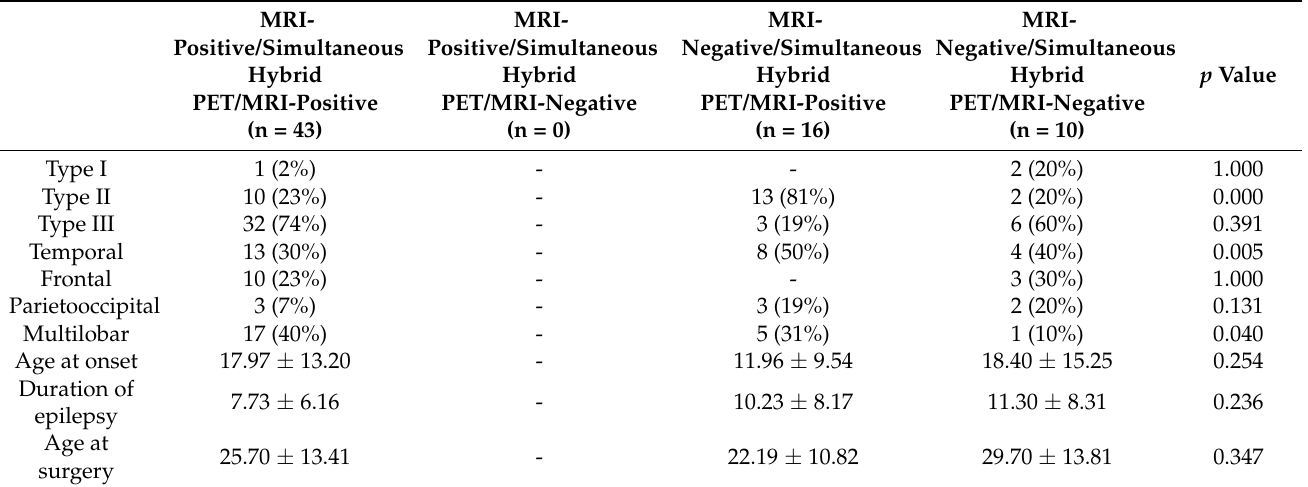
Table 4. MRI-positive/Simultaneous Hybrid PET/MRI-positive, MRI-positive/Simultaneous Hybrid PET/MRI-negative, MRI-negative/Simultaneous Hybrid PET/MRI-positive, and MRI- negative/Simultaneous Hybrid PET/MRI-negative